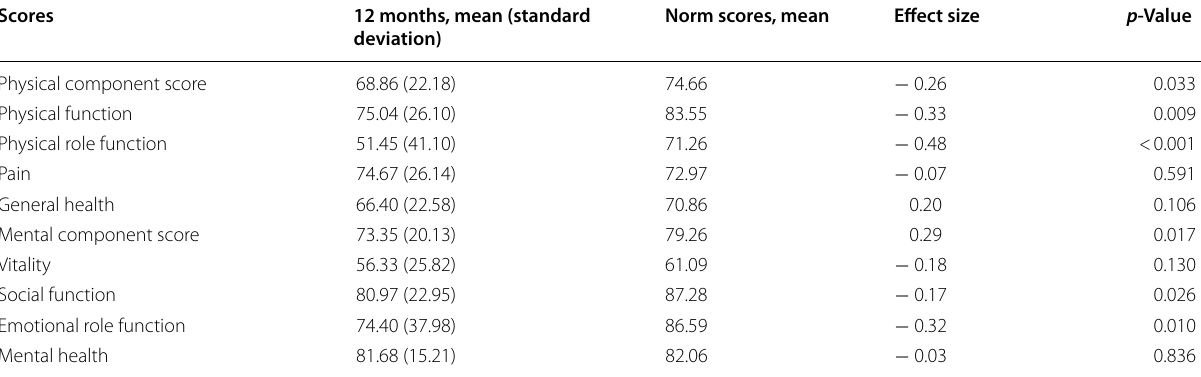
Norm scores were adjusted for age and gender to reflect the same distribution as the study sample Effect sizes were calculated by subtracting the mean score of the population norm from the mean score of the patient group divided by the standard deviation of the patient group. Effect sizes < 0.2 are considered trivial, from 0.2 to < 0.5 are considered small, from 0.5 to < 0.8 as moderate and